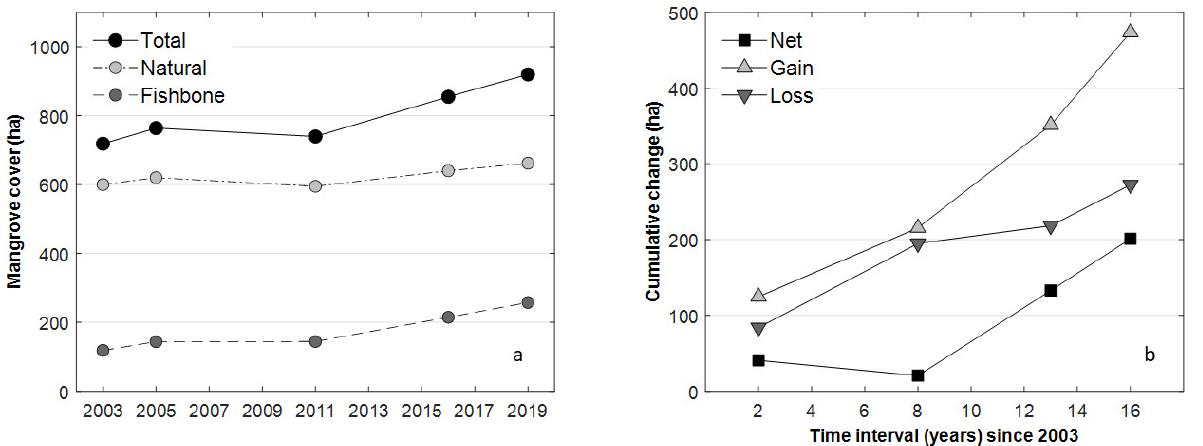
Figure 5. Change in cover among total, natural, and artificial mangrove area ( a ). Cumulative gross gain, gross loss, and net gain of mangrove cover at different time intervals since 2003 ( b ).